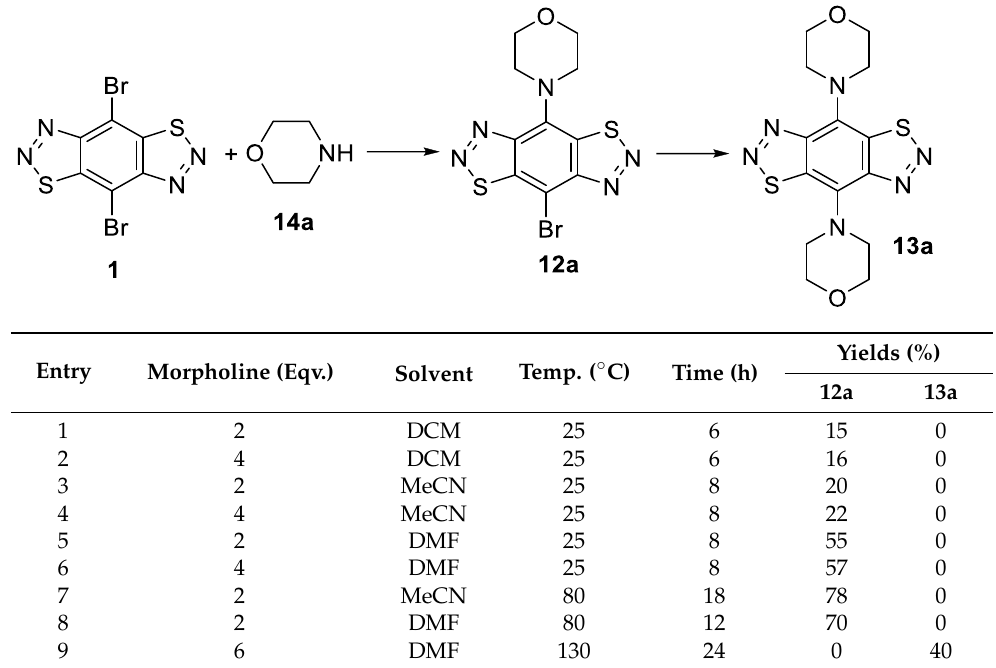
Table 2. Nucleophilic substitution of 4,8-dibromobenzo[1,2- d :4,5- d ’ ]bis([1,2,3]thiadiazole) 1 with morpholine.